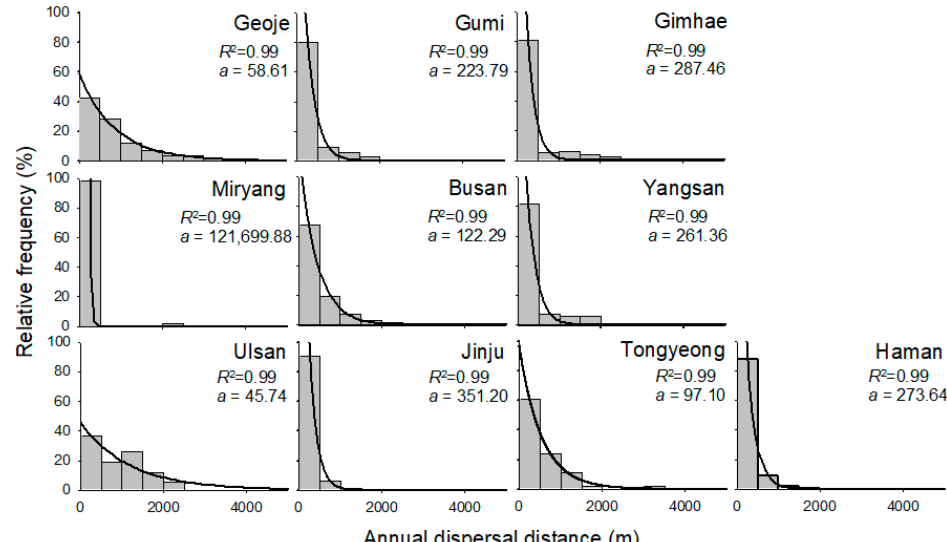
Figure 3. Frequency of annual dispersal distances in ten different study regions: Geoje, Gumi, Gimhea, Miryang, Busan, Yangsan, Ulsan, Jinju, Tongyeong, and Haman. The lines were fitted by the exponential decay function.